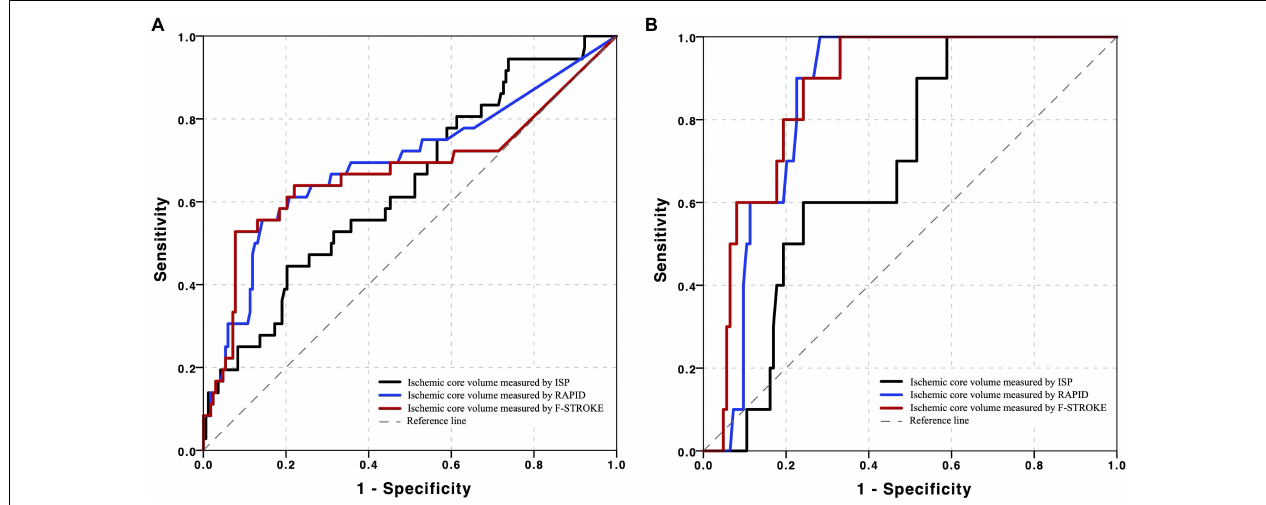
FIGURE 4 | Receiver operating characteristic (ROC) curves of ischemic core volume calculated by three computed tomographic perfusion (CTP) software packages in predicting unfavorable clinical outcomes in all the patients in panel (A) and patients achieved complete reperfusion in panel (B) after EVT.